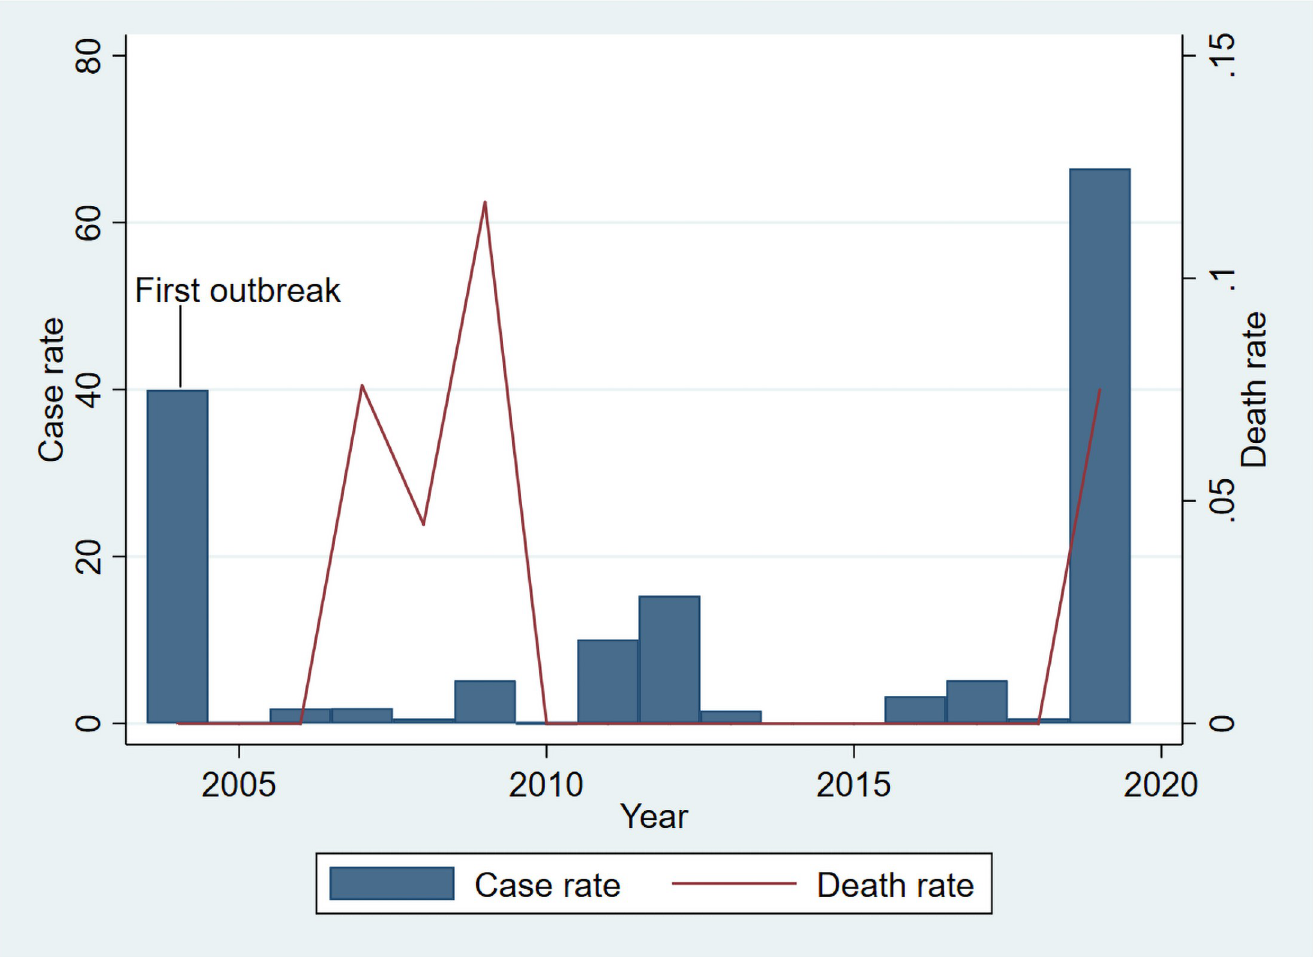
Fig 1. Dengue incidence and death rate (per 10,000) in Bhutan, 2004–2019 (source, Annual Health Bulletin, Royal Centre for Disease Control, and WHO-SEARO).